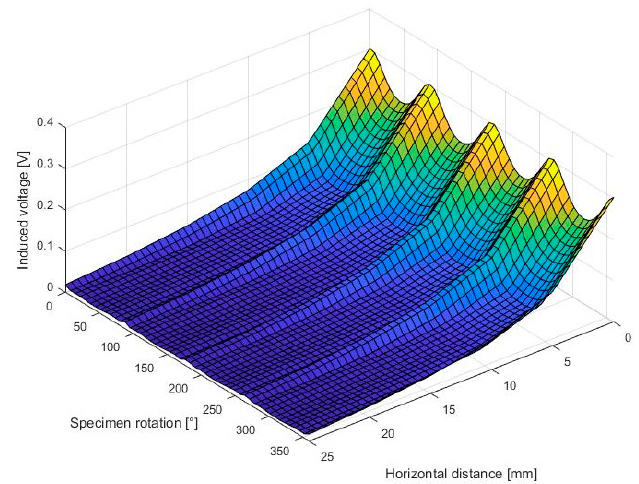
Figure 5. Position sensitive signal characteristics of PCB based sensors when analysing a one-layer woven carbon fibre textile.